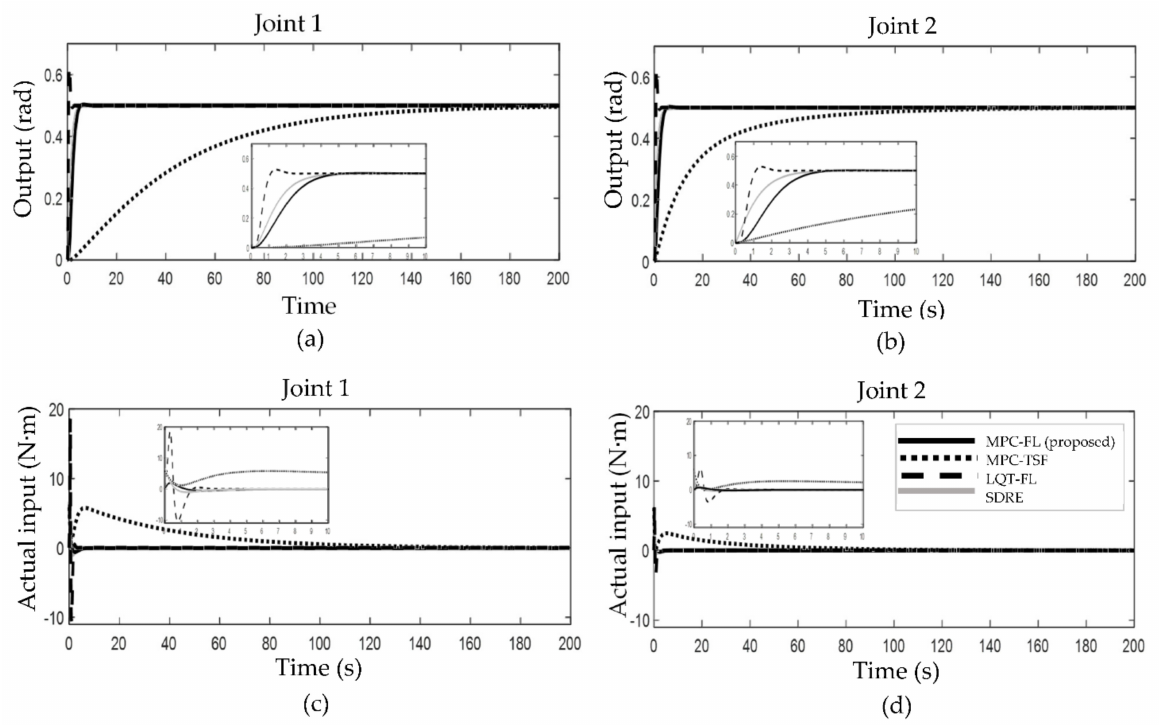
Figure 10. Two-link robot arm by applying the four control schemes without input constraints: ( a ) output responses of joint 1; ( b ) output responses of joint 2; ( c ) input signals of joint 1; ( d ) input signals of joint 2.